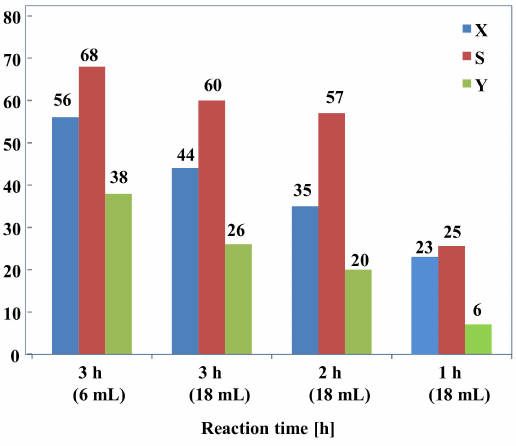
Figure 7. Fructose conversion ( X ), selectivity to HMF ( S ) and yield ( Y ) obtained in the catalytic experiments carried out at 165 ◦ C by using an initial fructose concentration of 0.3 M and in the presence of Nb 2 O 5 (2 g · L − 1 ).